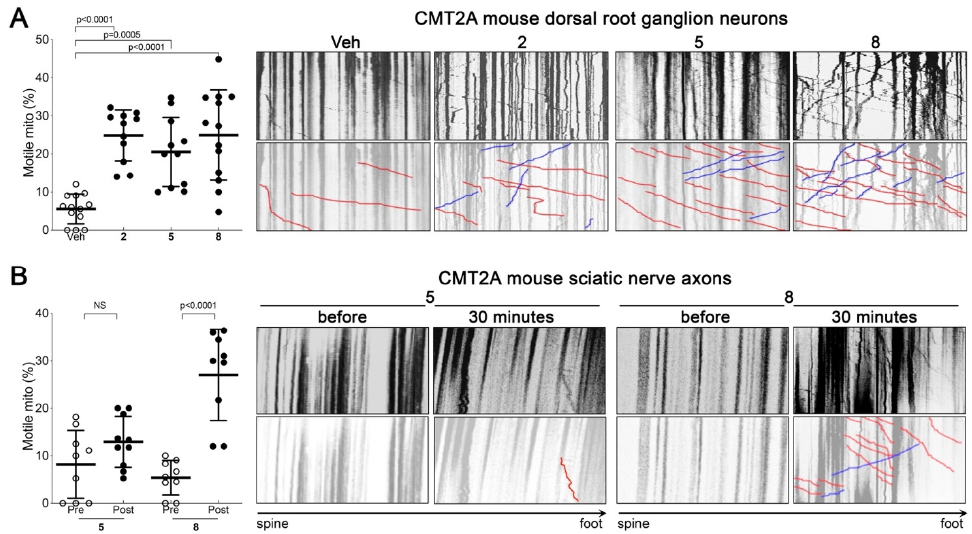
Figure 9. Compound 5 and 8 effects on mitochondrial motility in CMT2A neurons. ( A ) Experiments in cultured DRGs from MFN2 T105M Mice. (left) Group data. Each point is a different neuron, from two independent CMT2A mouse preparations; p values are from ANOVA. (right) representative kymographs of the different treatment groups. Top is raw data; bottom emphasizes motile mito- chondria. ( B ) Experiments in explanted sciatic nerves from MFN2 T105M mice. (left) Group data before and 30 min after topical application of 1 μ M indicated compound; p values are from t -test. (right) representative kymographs, as in ( A ).